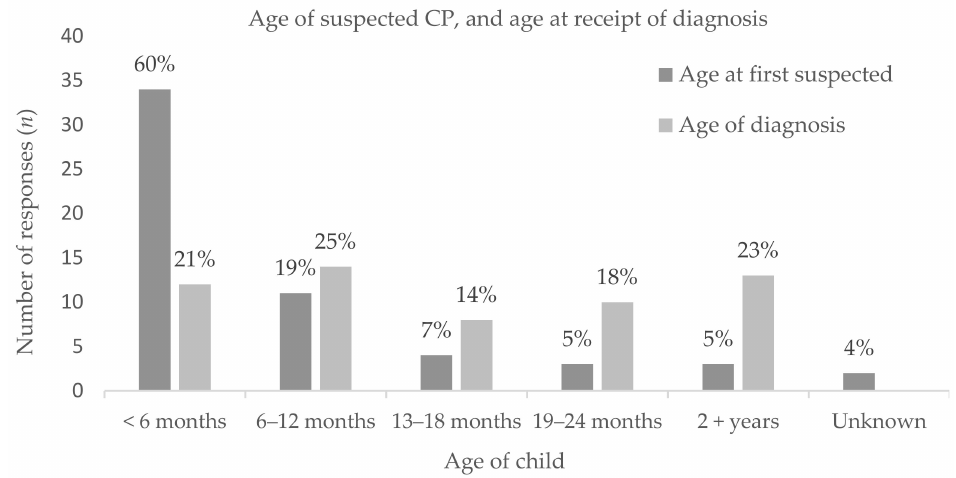
Figure 1. Age of child whereby families first suspected that their child may have CP (or a like condition), vs. the age the family was given a diagnosis of CP (Cerebral Palsy).